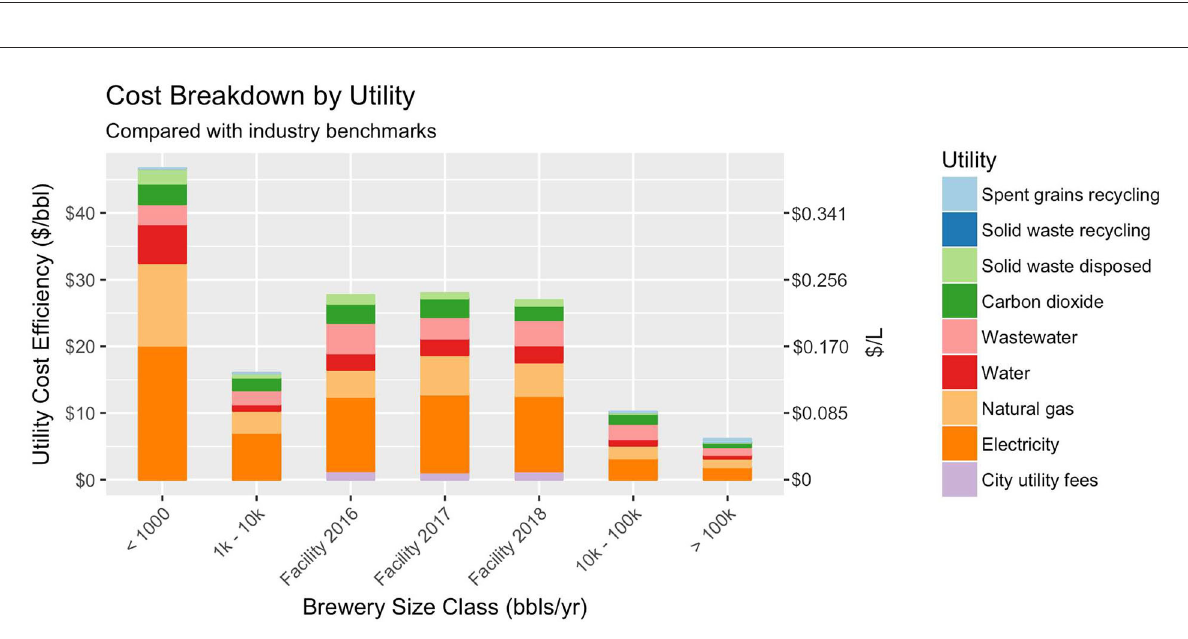
FIGURE6 Specific utility cost ($/bbl packaged and $/L packaged) for case study brewery in 2016–2018 with all utilities stacked, compared with peer facilities of varying sizes [Benchmark data are from 2014 (Brewers Association,